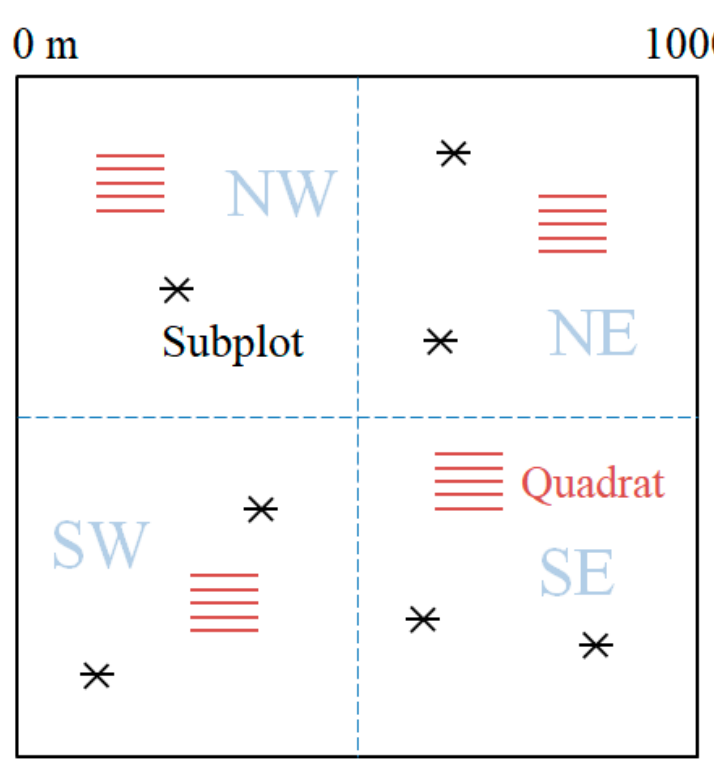
Figure 3. Example of quadrat and sub-plot distribution within 1.0 km LAI research site (Fairystone research site only). Note: One quadrat sites (Hertford, Umstead, Appomattox).